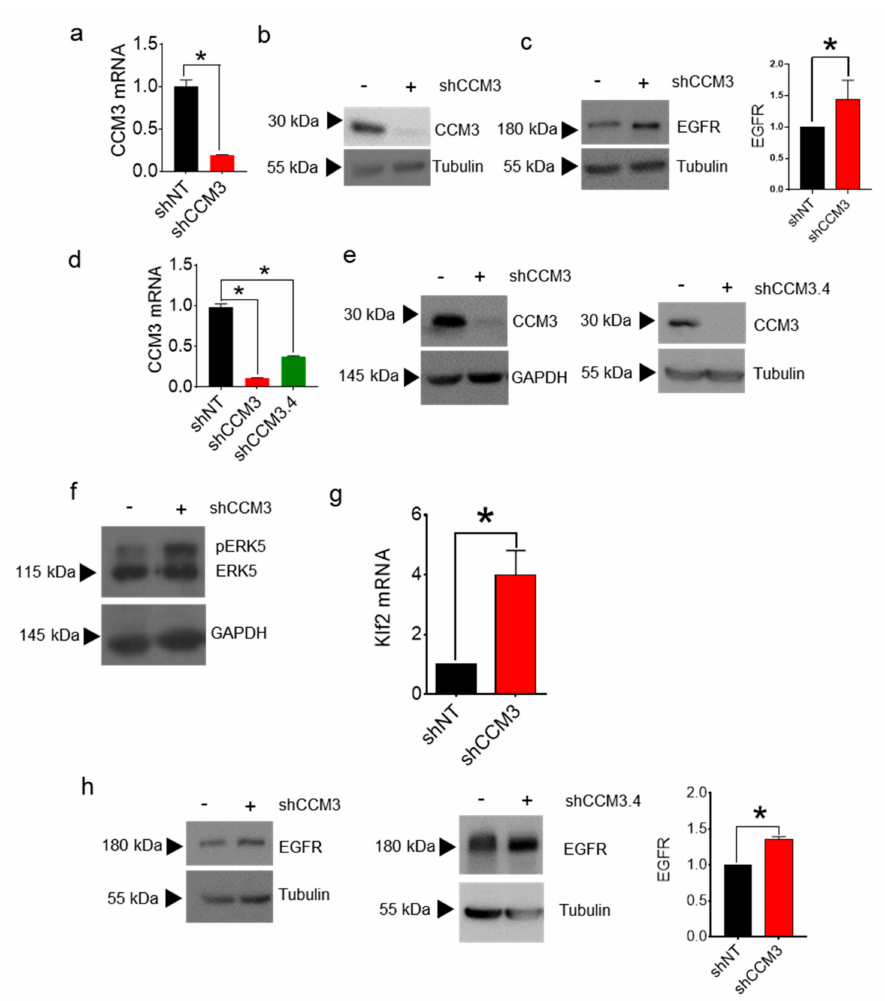
Figure 2. Receptors of the EGFR family are upregulated in several CCM3-deficient cells; ( a ) mRNA levels, and ( b ) Protein levels, of CCM3 in in hCMEC / D3 endothelial cells transduced with shNT and shCCM3 shRNAs. * p < 0.001; ( c ) Western blot of EGFR in hCMEC / D3 cells transduced as in ( a ). Right panel: quantification of EGFR Western blots. * p < 0.05; ( d ) mRNA levels; and ( e ) Protein levels, of CCM3 in A549 cells transduced with shNT, shCCM3, or shCCM3.4 shRNAs; ( f ) Western blot of ERK5 in A549 cells transduced with shNT or shCCM3 shRNAs; ( g ) mRNA levels of KLF2 in cells transduced as in ( f ); ( h ) Western blot of EGFR in A549 cells transduced with shNT, shCCM3 or shCCM3.4 shRNAs. Right panel: quantification of EGFR Western blots. * p <